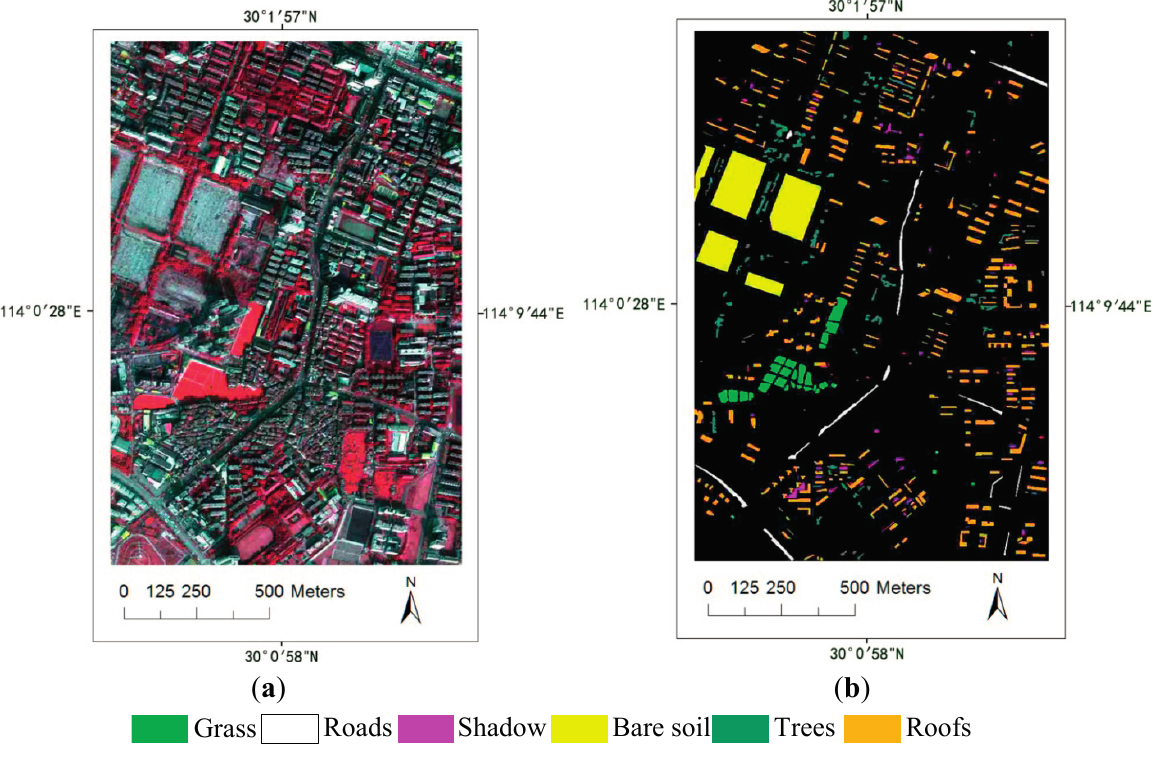
Roads Shadow Bare soil TreesGrass